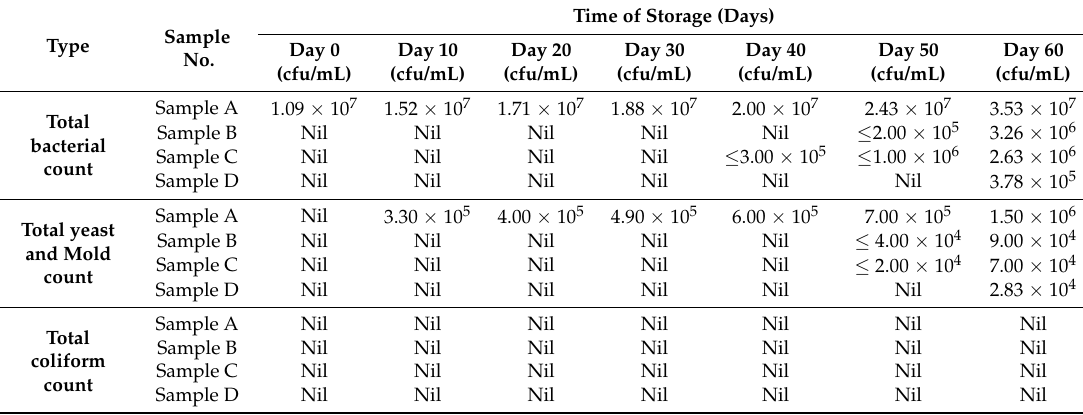
Table 2. Evaluation of total viable count of samples over storage